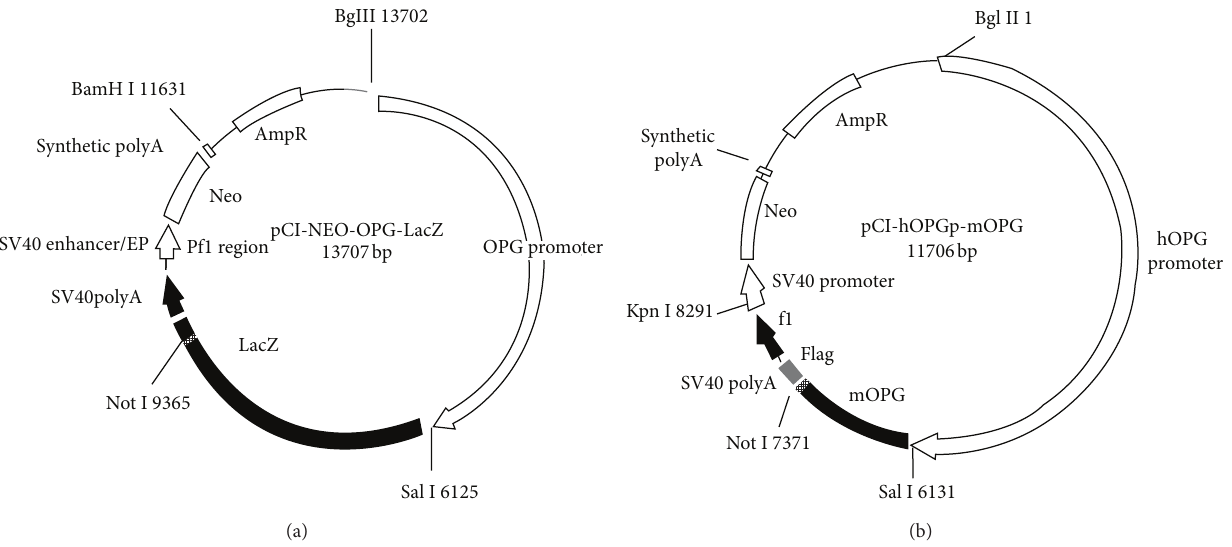
Figure 1: Structure scheme of plasmids. (a) PCI-NEO-OPG-LacZ plasmid profile. (b) PCI-hOPGp-mOPG plasmid profile.